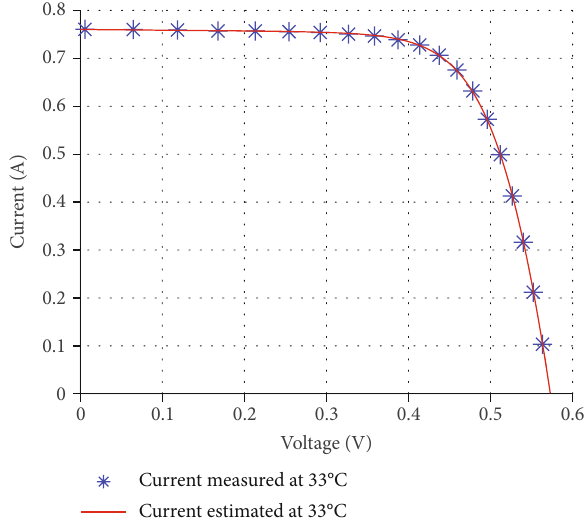
Figure 6: Estimated and measured current curves for the double diode The predicted (red solid line) and experimental (blue dashed line) current-voltage characteristics of the R.T.C.